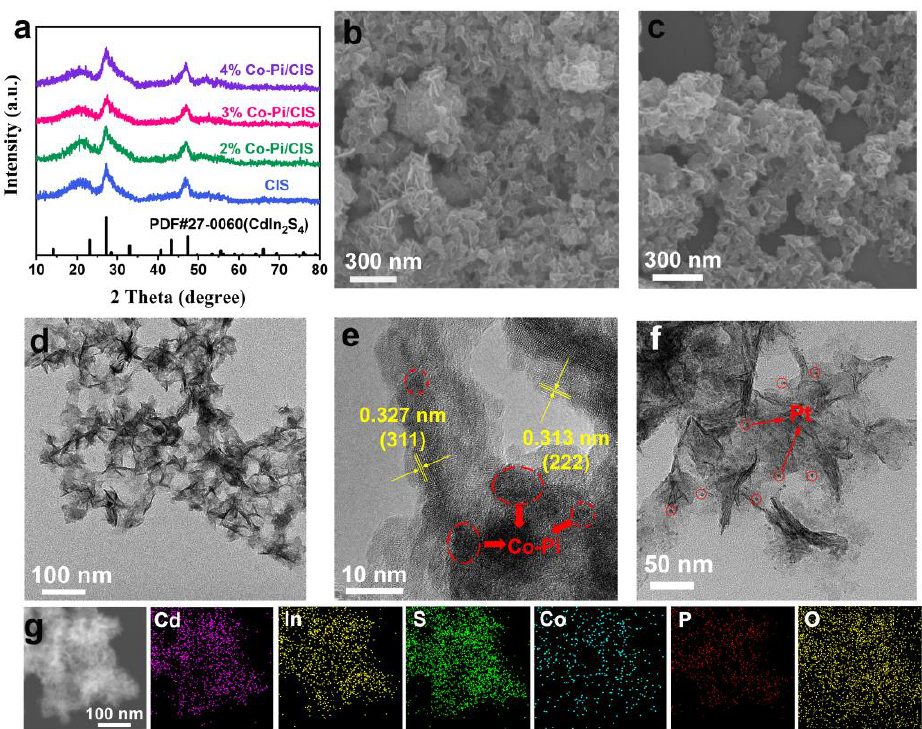
Figure 1. ( a ) X-ray diffraction (XRD) patterns of CdIn 2 S 4 (CIS) and x% CoH x PO y /CdIn 2 S 4 (Co-Pi/CIS). scanning electron microscopy (SEM) images of ( b ) CIS and ( c ) Co-Pi/CIS. ( d ) transmission electron microscopy (TEM) and ( e ) high-resolution TEM (HRTEM) images of Co-Pi/CIS. ( f ) TEM image of Pt/CIS. ( g ) TEM image and corresponding energy dispersive X-ray spectroscopy (EDS) elemental mapping of Co-Pi/CIS.